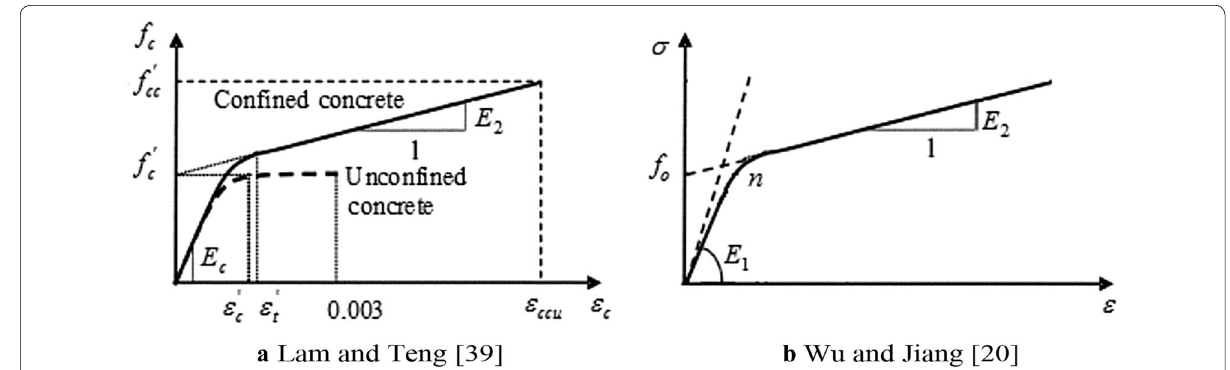
Fig. 9 Stress–strain models of FRP‑confined